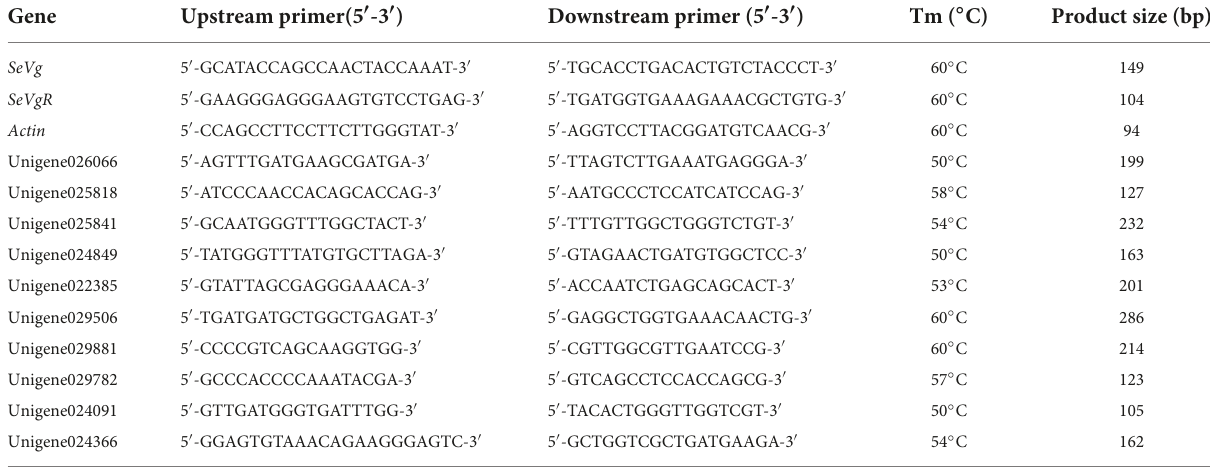
TABLE 2 Sequences of RT-qPCR primers used in this study. Gene